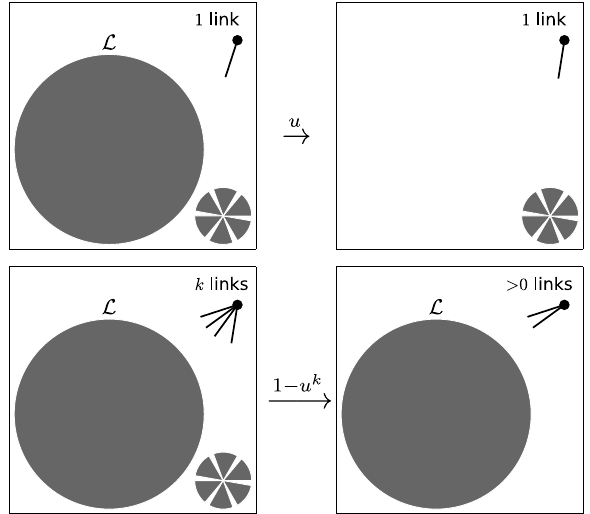
FIG. 7. We base our theory on the method to calculate the size of normal giant components, as illustrated in this figure. Using a self-consistency equation, the probability u can be calculated. This is the probability that a node is not connected to the giant component over a single link (see top). On the bottom, the probability for a node with k links is illustrated to have at least one link connecting to the giant component. Note that u k is the probability that all links fail.